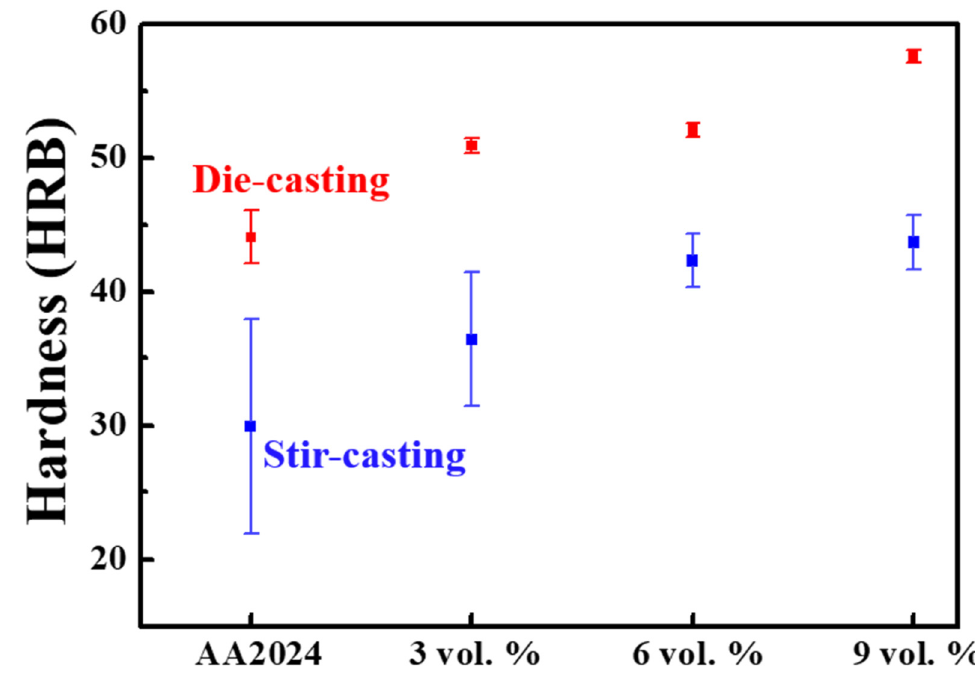
Figure 7. Results of Rockwell hardness (B scale) measurement.